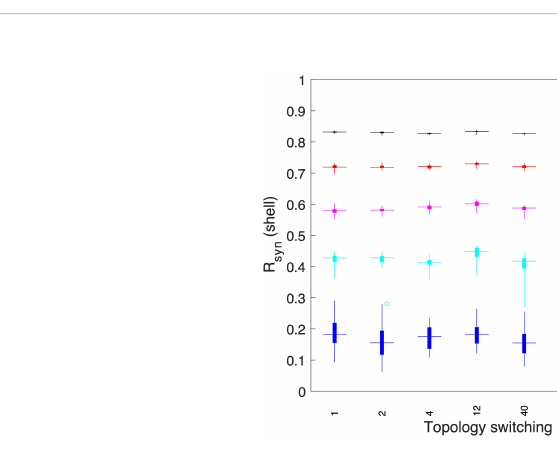
FIGURE 10 Effects of topologies switching between the core and shell coupling during individual simulations. Synchronization levels were examined under different photoperiods. During short photoperiods (PP 8 and 10), when the synchronization is almost complete, topology switching doesn ’ t result in any signi fi cant effect on the system ’ s synchrony. When photoperiods are moderate, a fast topology switch can enhance the synchronization level of the core. Under long photoperiods when the synchronization level is relatively low, the topology switch failed to enhance the system ’ s synchronization. 50 realizations were conducted in our